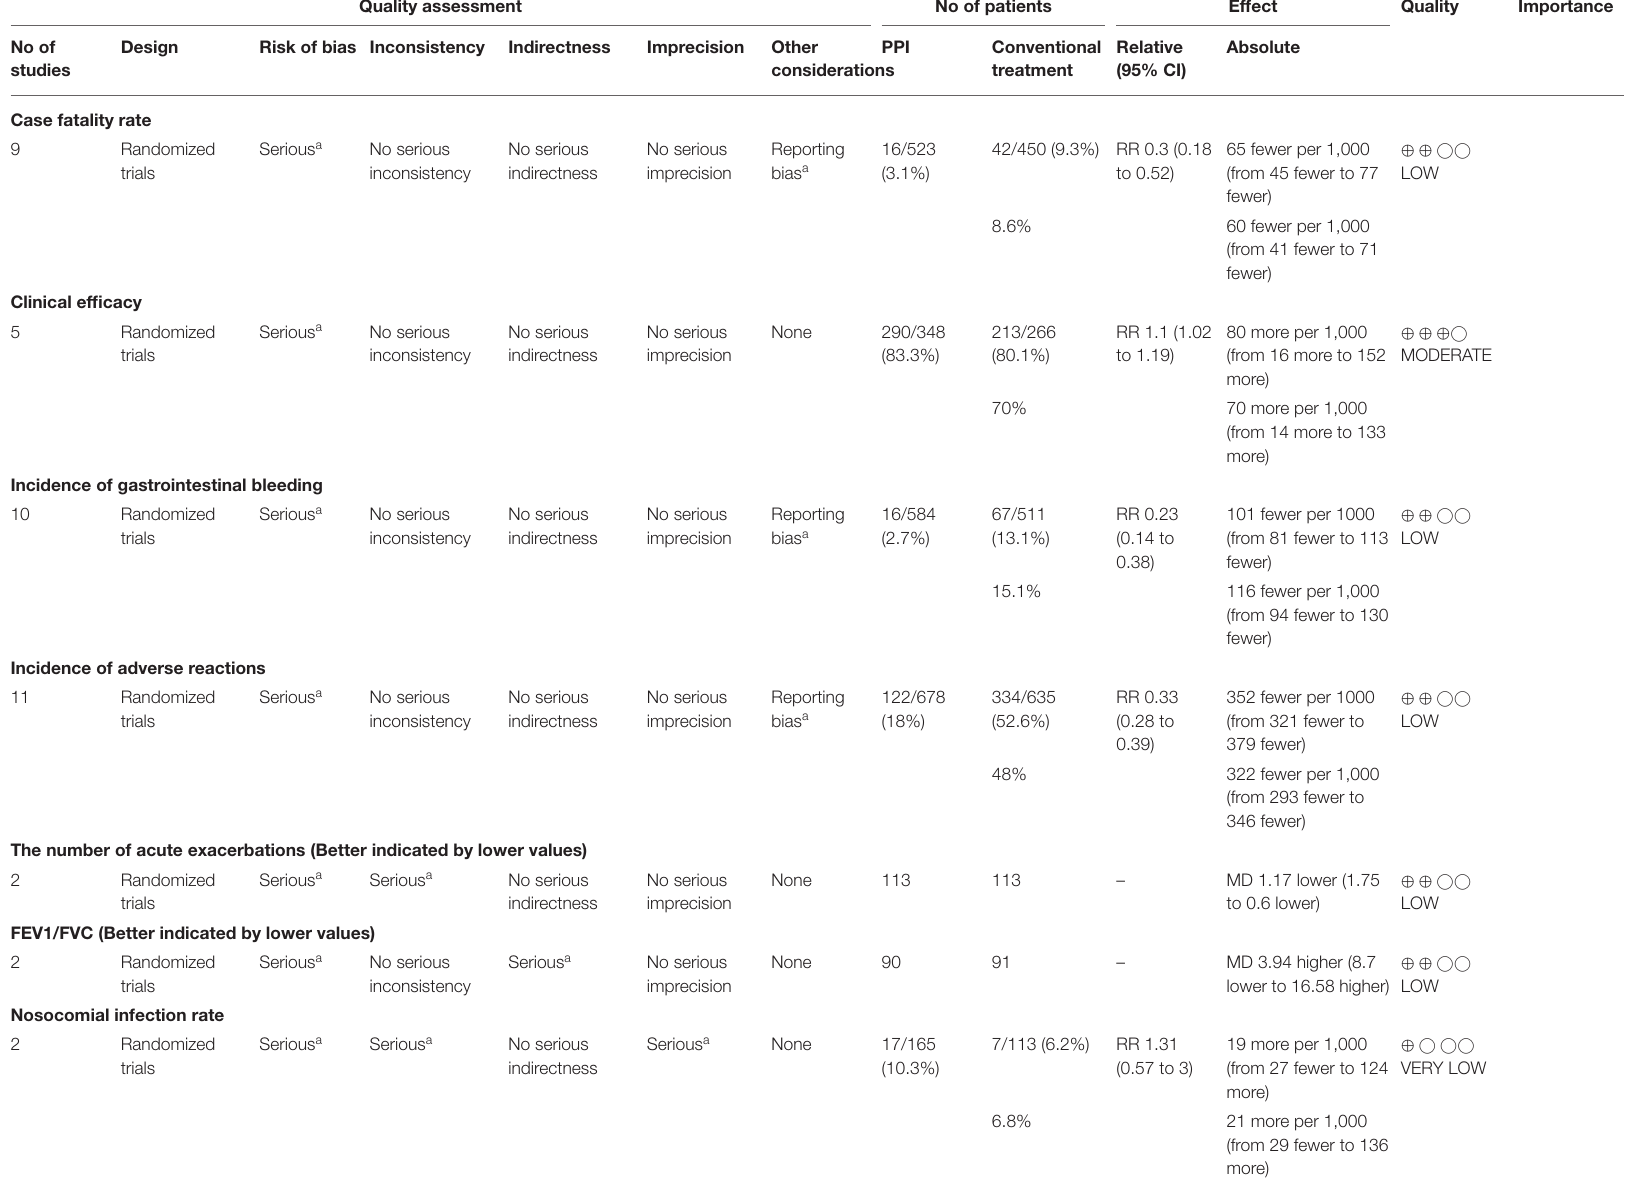
TABLE 2 | The evidence level of the outcomes obtained in this study was evaluated using